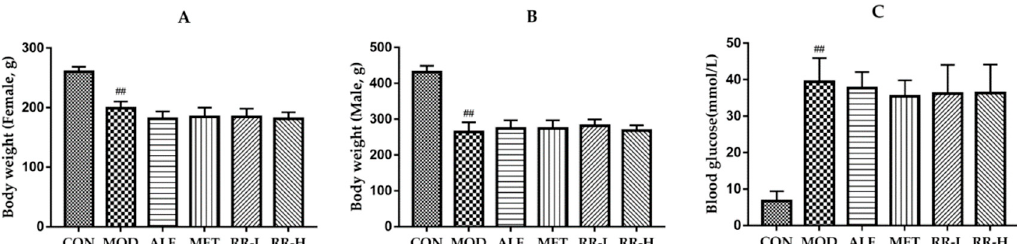
Figure 1. Effects of Rehmanniae Radix Praeparata (RR) on body weight and random blood glucose levels in diabetic rats after 8-week oral administration. ( A ) body weight of female rats; ( B ) body weight of male rats; ( C ) random blood glucose levels. All data are expressed as mean ± SD ( n = 5 for body weight; n = 10 for random blood glucose level). ## p < 0.01 as compared to control group.